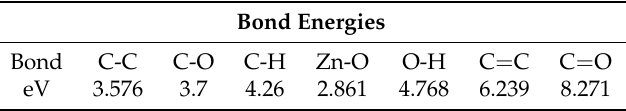
Table 1. Summary of the bond energies between carbon, oxygen, hydrogen, and zinc in zinc acetylacetonate hydrate [15].